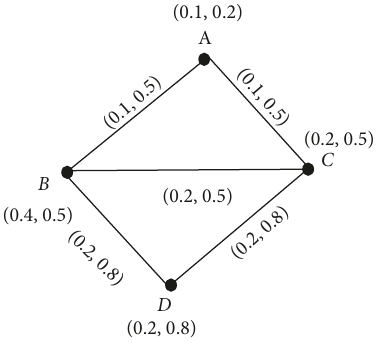
V, A , B 1 1 ) . (cid:29) (